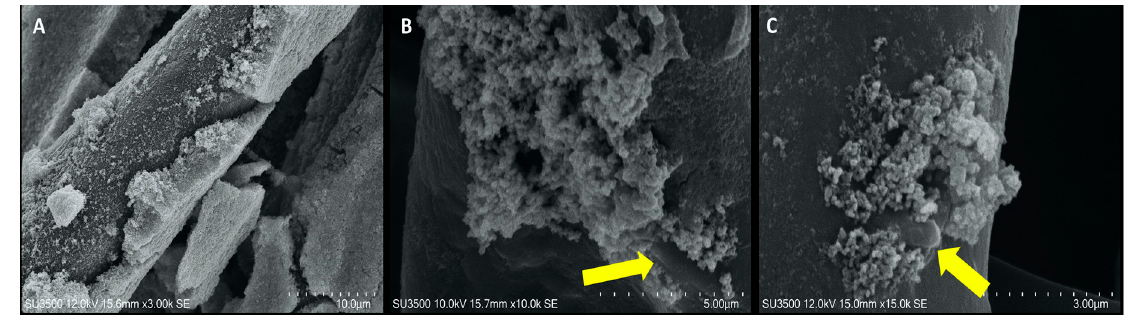
Figure 7. SEM microscopy of textiles used as filters. ( A ) 10% GO-coated fibers covered with a thick layer of the virus; ( B ) GO sheets (arrow) emerging from fiber surface, surrounded by virus particles; ( C ) GO sheets (arrow) surrounded by viral aggregates.